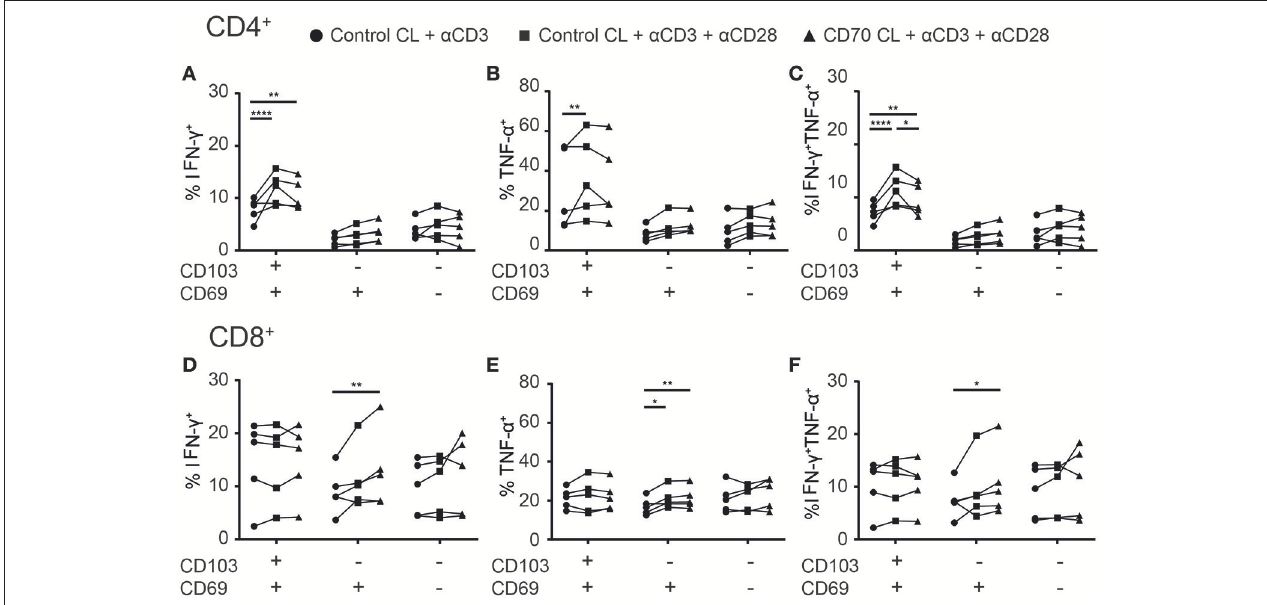
FIGURE 7 | Co-stimulation enhances cytokine production of TILs. (A–F) The effect of co-stimulation on cytokine production of TILs was assessed with overnight stimulation. (A–C) The frequencies of IFN- γ + (A) , TNF α + (B) , or TNF- α + IFN- γ + (C) CD103 + , CD69 + , and CD69 − CD4 + TILs stimulated with α CD3 with control cell line (CL) (black circles), α CD3 and α CD28 with control CL (black squares), or α CD3 and α CD28 with CD70-expressing CL (black triangles) was quantified. (D–F) The frequencies of IFN- γ + (D) , TNF α + (E) , or TNF- α + IFN- γ + (F) CD103 + , CD69 + , and CD69 − CD8 + TILs stimulated with α CD3 with control CL (black circles), α CD3 and α CD28 with control CL (black squares), or α CD3 and α CD28 with CD70-expressing CL (black triangles) was quantified. n = 5. * p < 0.05, ** p < 0.01, **** p < 0.0001; 2-way ANOVA with Tukey’s multiple comparisons